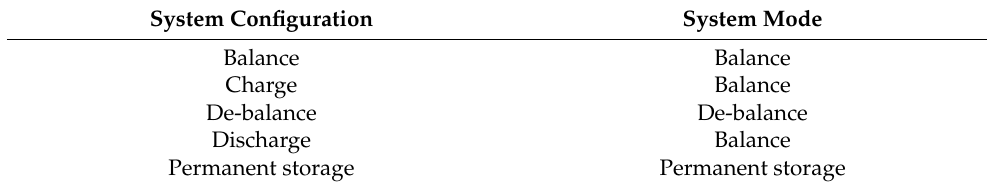
Table 1. List of system configurations and modes.